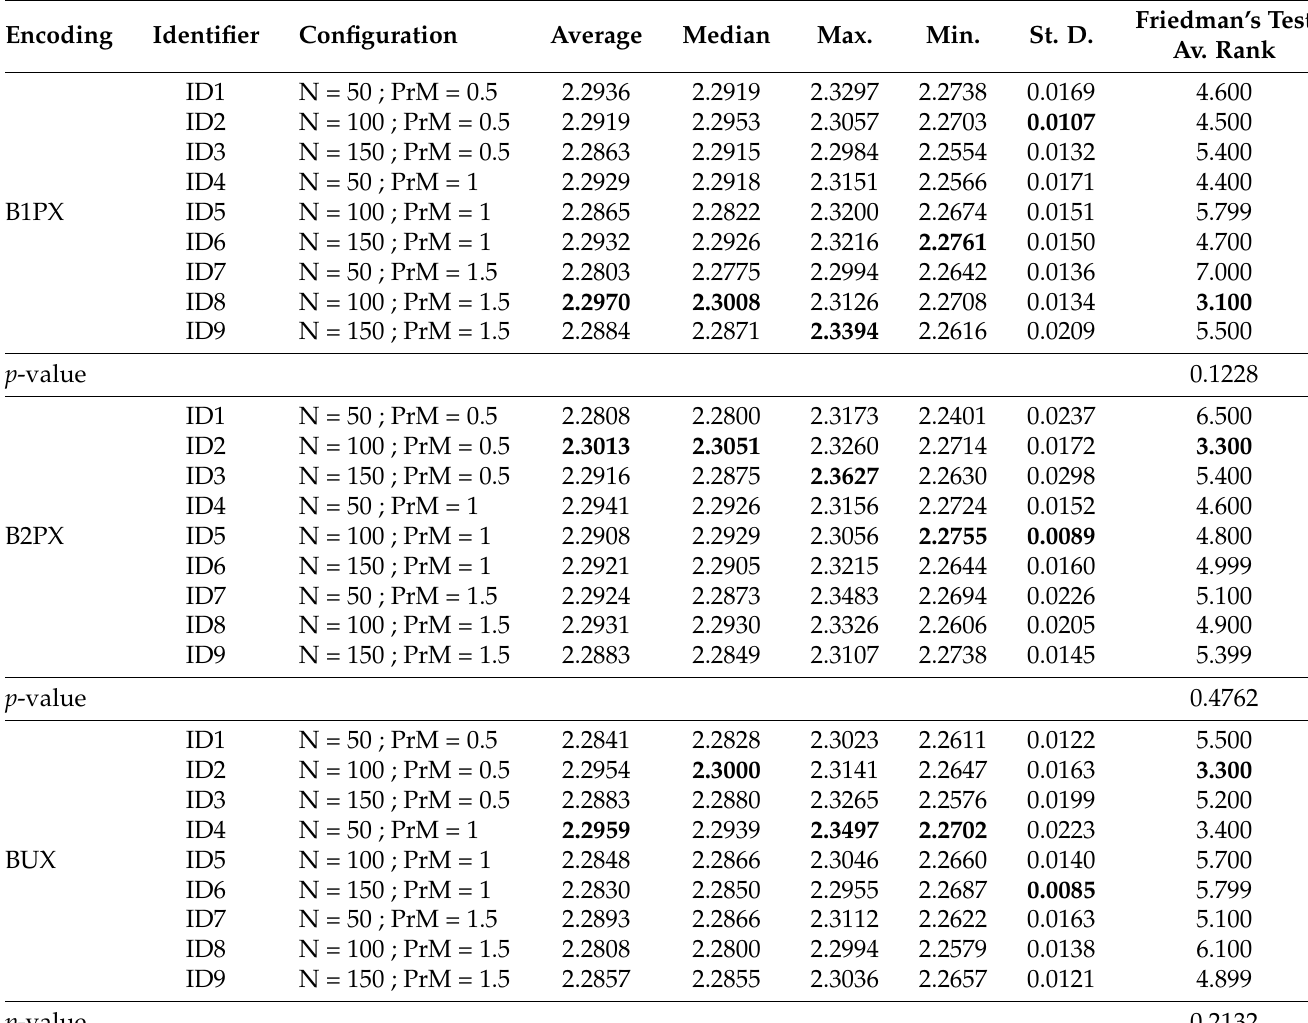
Table 5. Hypervolume statistics (Binary